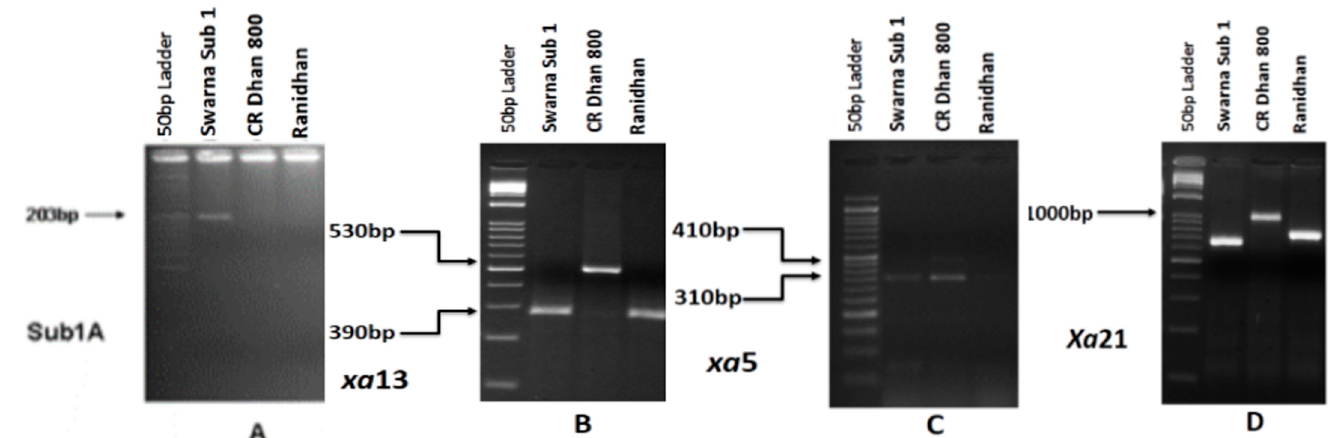
Figure 2. Agarose gel electrophoresis profile of parents ( A ) The presence of specific band size of 203 bp expected for Sub1A tolerance QTL in Swarna-Sub1 variety. Lane 1: 50 bp DNA ladder; Lane 2: Swarna-Sub1; Lane 3: CR Dhan 800; Lane 4: Ranidhan, showing the presence of xa13 ( B ), xa5 ( C ) and Xa21 ( D ) with their respective sizes.